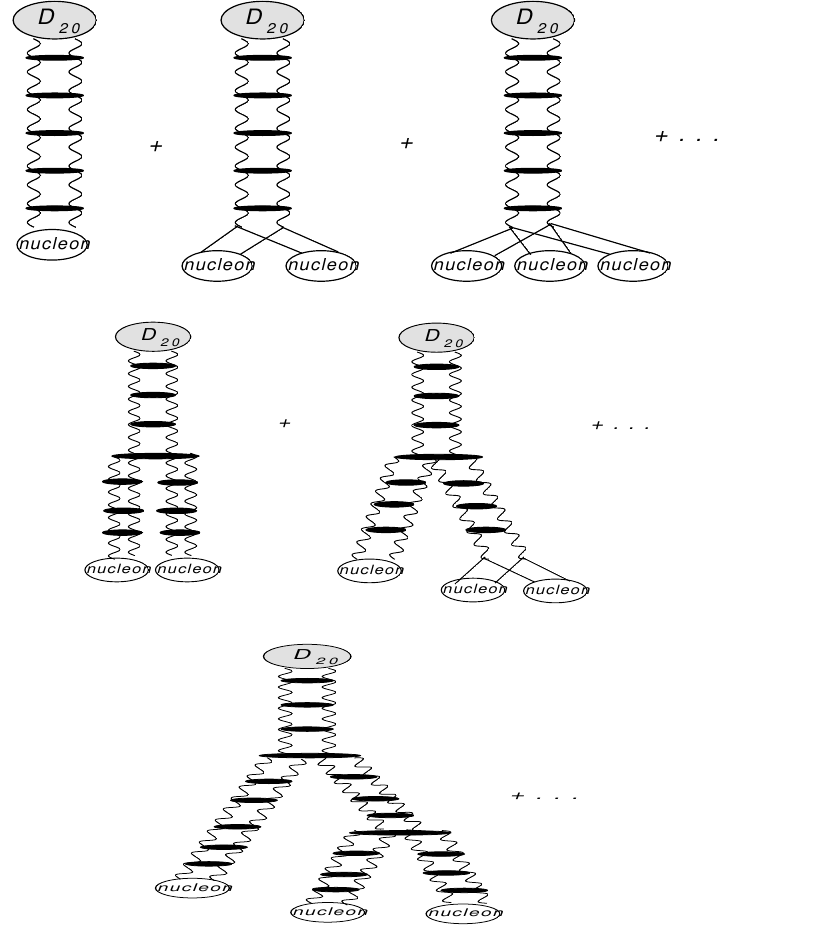
Figure 13 . Illustrating our main results: in the upper line the single pomeron can couple to one, two, three nulceons; in the second line we show the (cid:12)rst fan diagram with couplings to one, two nucleons; in the third line we have the second order fan diagrams with couplings to single